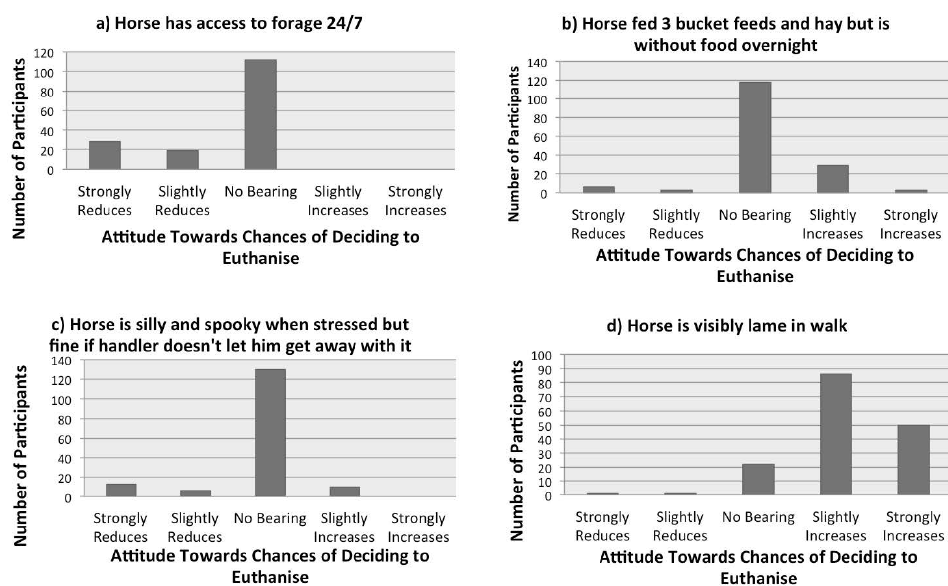
Figure 1. Sample items from the key four factors, labelled (as described in Section 4) ( a ) Ethology- informed Management, ( b ) Traditional Horse Management, ( c ) Emotional Issues, ( d ) Physical Issues.